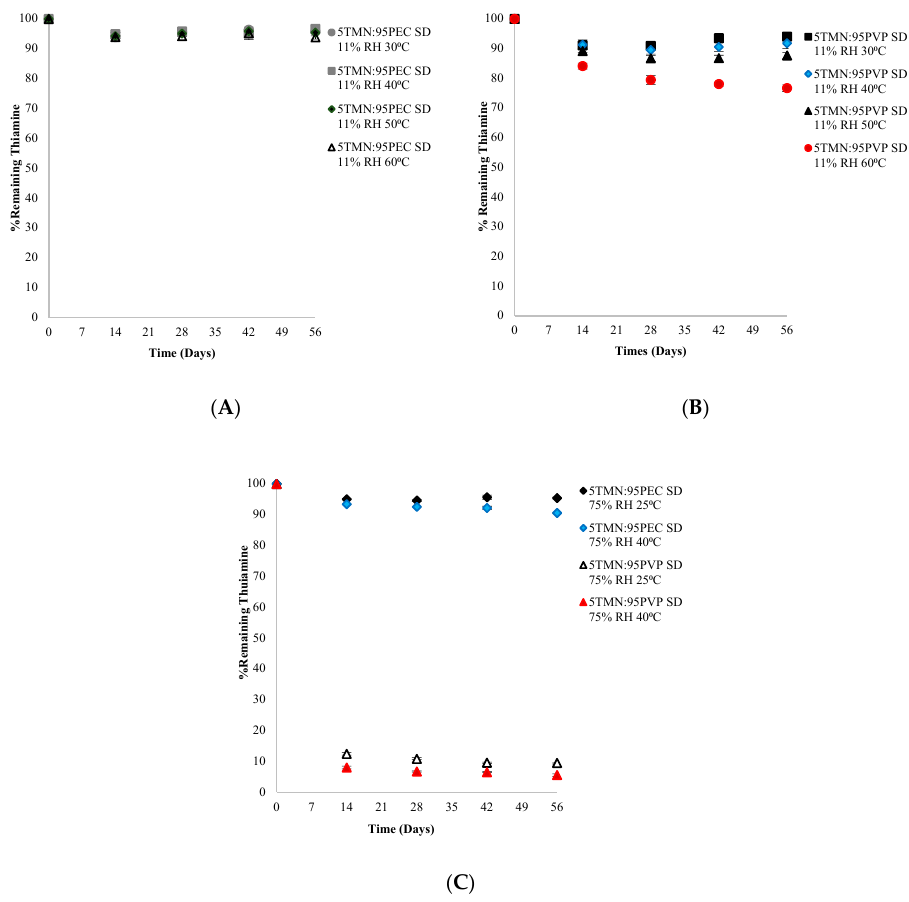
Figure 6. Chemical stability of thiamine ( A ) in 5TMN:95PEC solid dispersions (SD), ( B ) in 5TMN:95PVP dispersions (SD) stored at 11% RH and 30–60 °C for 56 days, and ( C ) in 5TMN:95PEC solid dispersions (SD) and 5TMN:95PVP dispersions stored at 75% RH and 25 or 40 °C for 56 days.